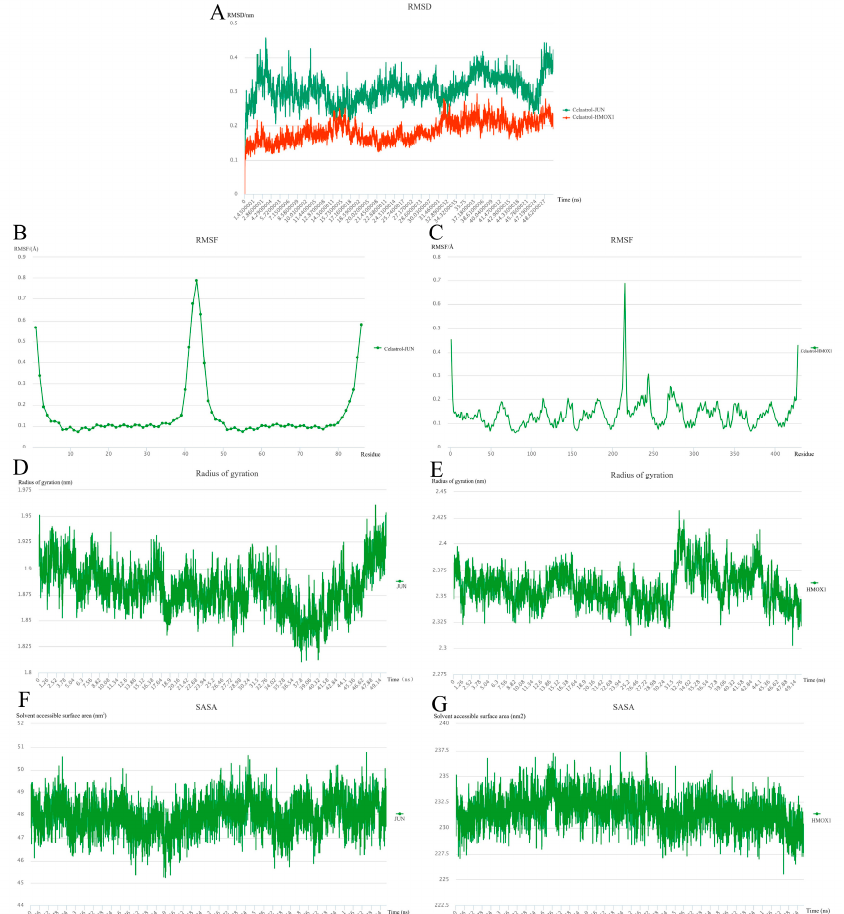
Figure 7. Molecular dynamics simulation for 50 ns. ( A ) RMSD of Celastrol–JUN and Celastrol– HMOX1. ( B , C ) The per-residue RMSF of Celastrol bound with JUN and HMOX1. ( D , E ) Rg of Celastrol–JUN and Celastrol–HMOX1. ( F , G ) The SASA of Celastrol bound with JUN and HMOX1.